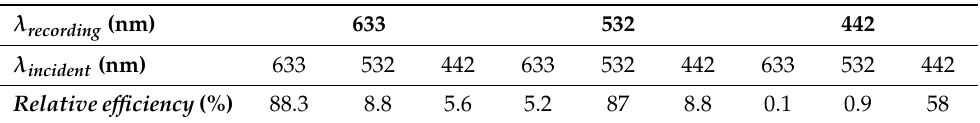
Table 4. Efficiency measured when each sample, recorded with a different wavelength, was illumi- nated with each